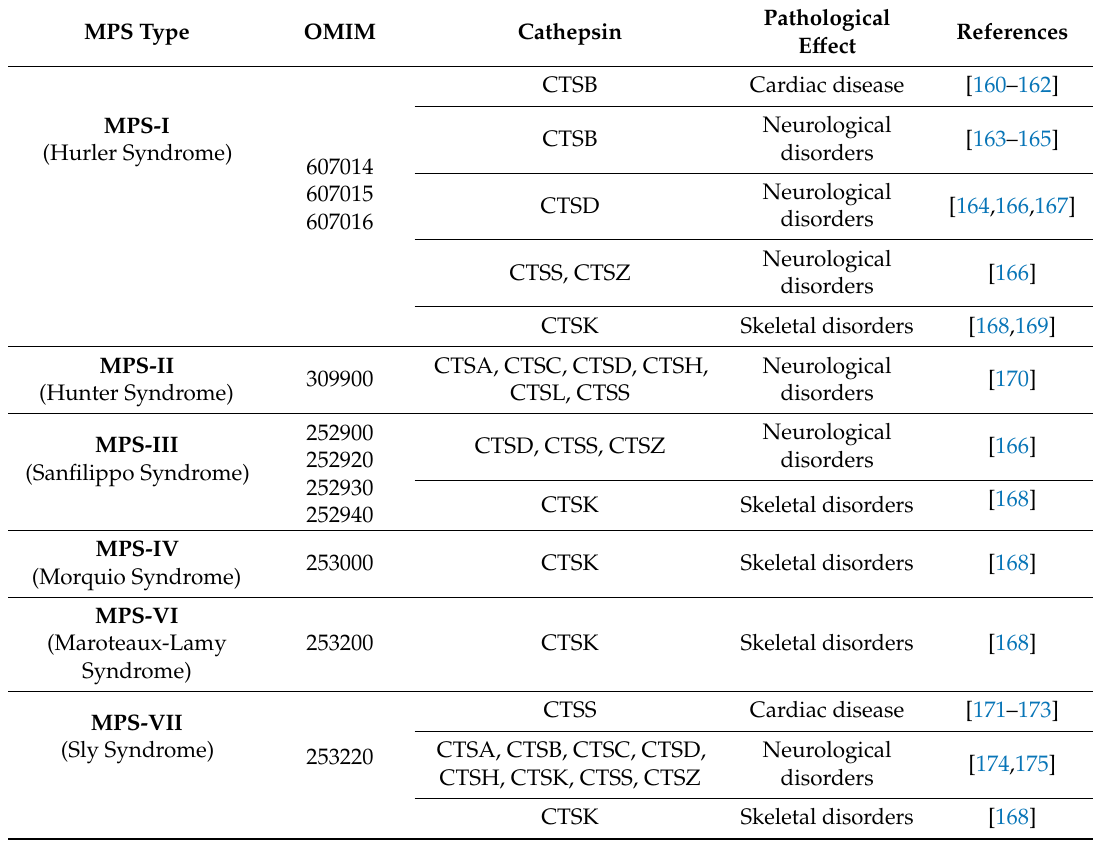
Table 3. Cathepsin involvement in mucopolysaccharidoses